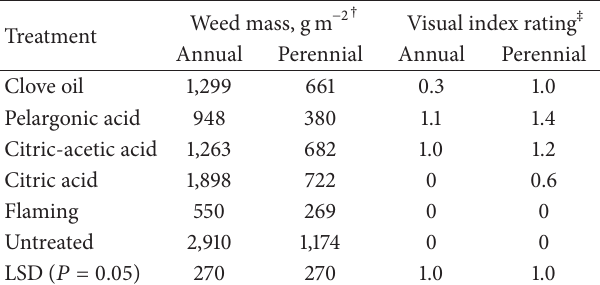
Table 9: Main effects of herbicide treatments on end-of-season weed mass and visual index rating of annual and perennial vege- tation (Field Experiment